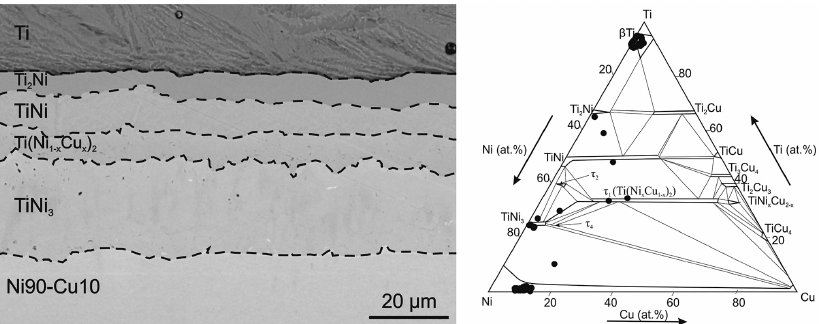
Figure 6: Left – the microphotography showing grown intermetallic phases, right – the diffusion path in diffusion couple experiment Ti-Ni90Cu10 at 1,123 K after 160